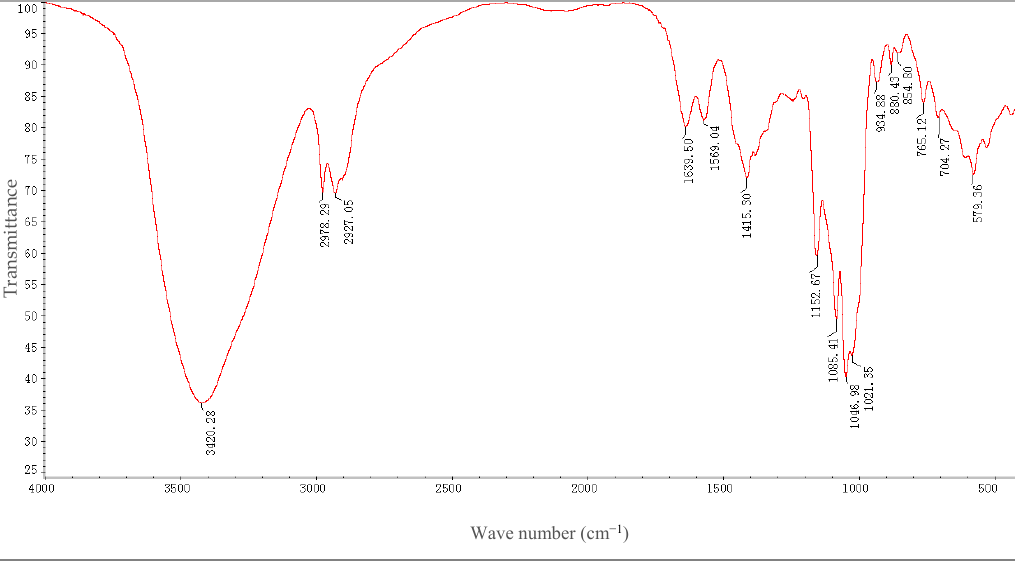
Figure 2. The infrared spectra of H-1-2.